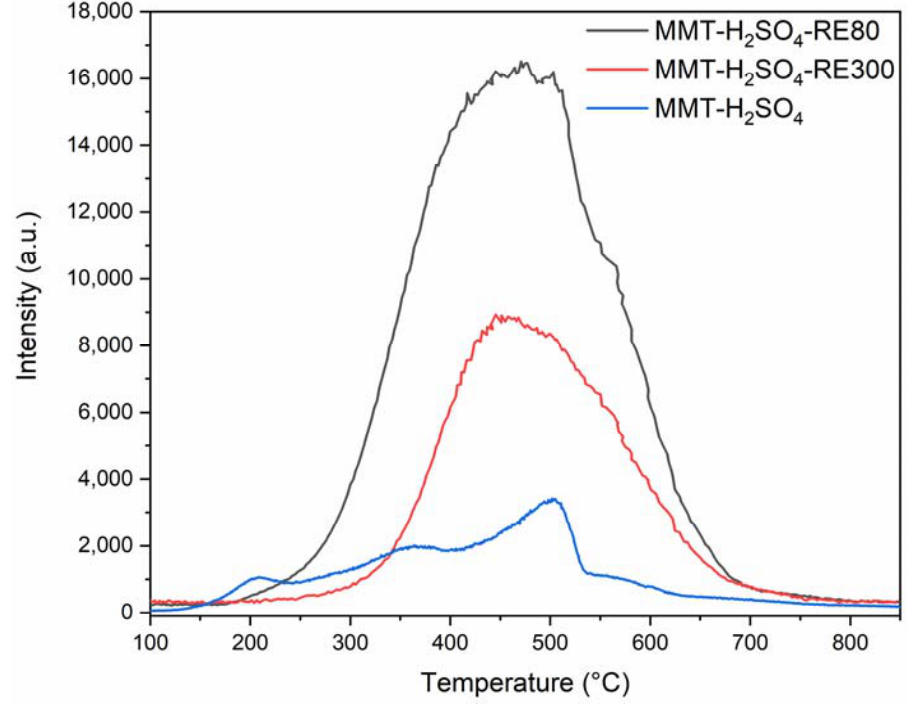
Figure 4. TPO-MS signal of originating carbon dioxide (m/z = 44).